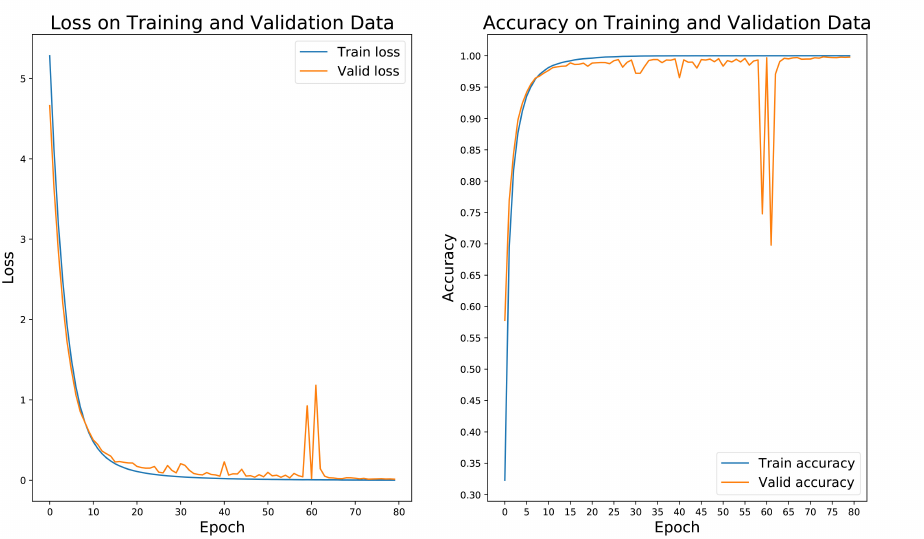
Figure 9. Loss and accuracy of the 2-D convolutional neural network (CNN) network model with the Aishell-1 dataset. The left part of the figure describes the loss vs. training epochs, and the right part describes the accuracy vs. training